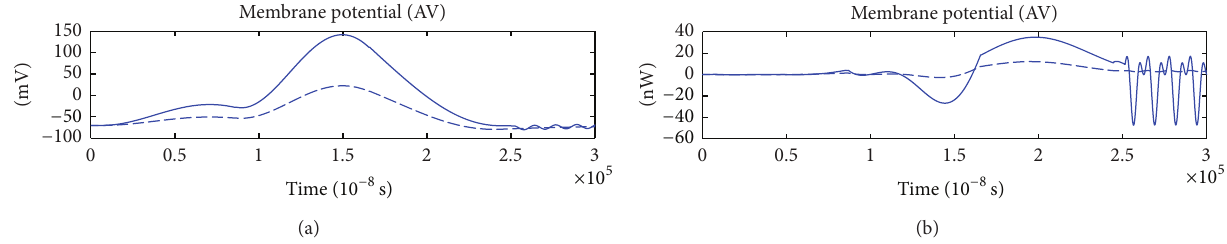
Figure 5: The action potential and its corresponding energy function. 𝑟 0𝑚 = 0.0001 Ω , 𝑟 1𝑚 = 0.1 Ω , 𝑟 2𝑚 = 1000 Ω , 𝑟 3𝑚 = 0.1 Ω , 𝑟 𝑚 = 1000 Ω , = 1 𝜇 F, 𝐿 = 50 𝜇 H, 𝑖 = 70.7 𝜇 A, and 𝑄 = 1 × 10 −4 𝜇 A. 𝐶 𝑚 𝑚 0𝑚